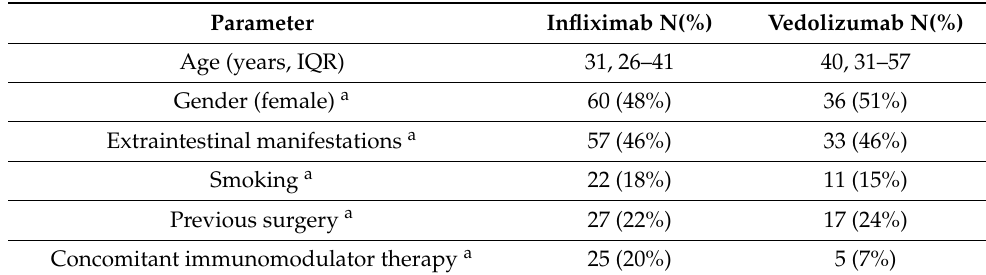
Table 1. Background disposition and clinical